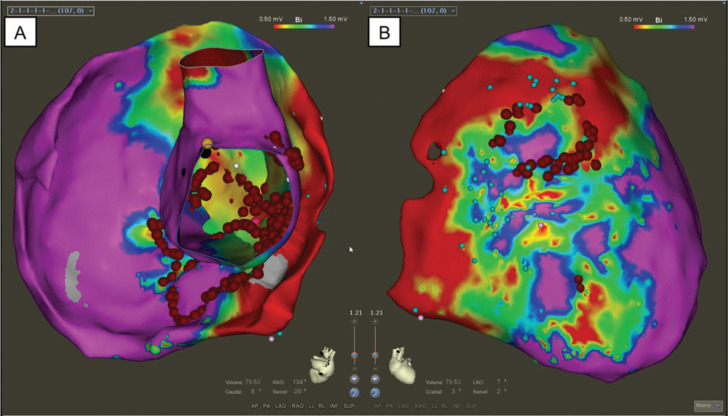
A: A 3D CARTO (Biosense Webster, Diamond Bar, CA) electroanatomic map with an internal view of the RV epicardial shell with RV endocardial shell superimposed on it with ablation lesion tags (red circles) in a patient with biventricular non-compaction. Bipolar voltage scale is from 0.5 to 1.5 mV with < 0.5 mV as dense scar and > 1.5 mV as normal voltage. B: The epicardial surface with ablation lesion tags.20